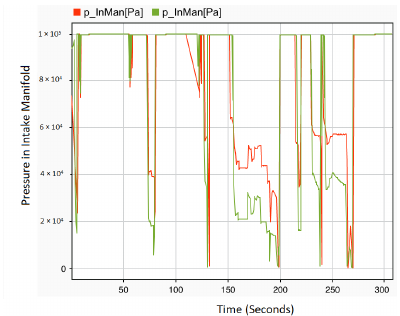
Figure 13. Intake manifold with ignition angle control signal stuck-at fault injection.